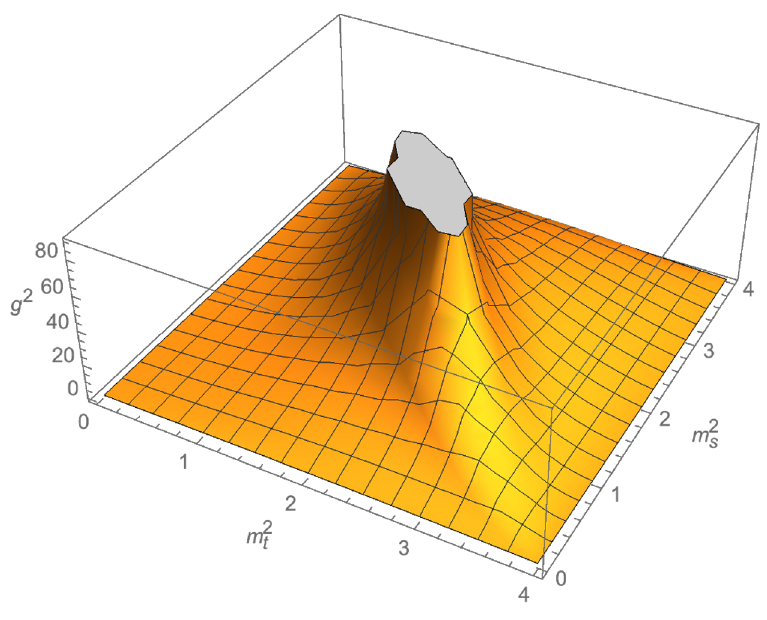
Figure 19 . O(8) bound on coupling to a ( t ) particle in the presence of an extra ( s ) particle. Open